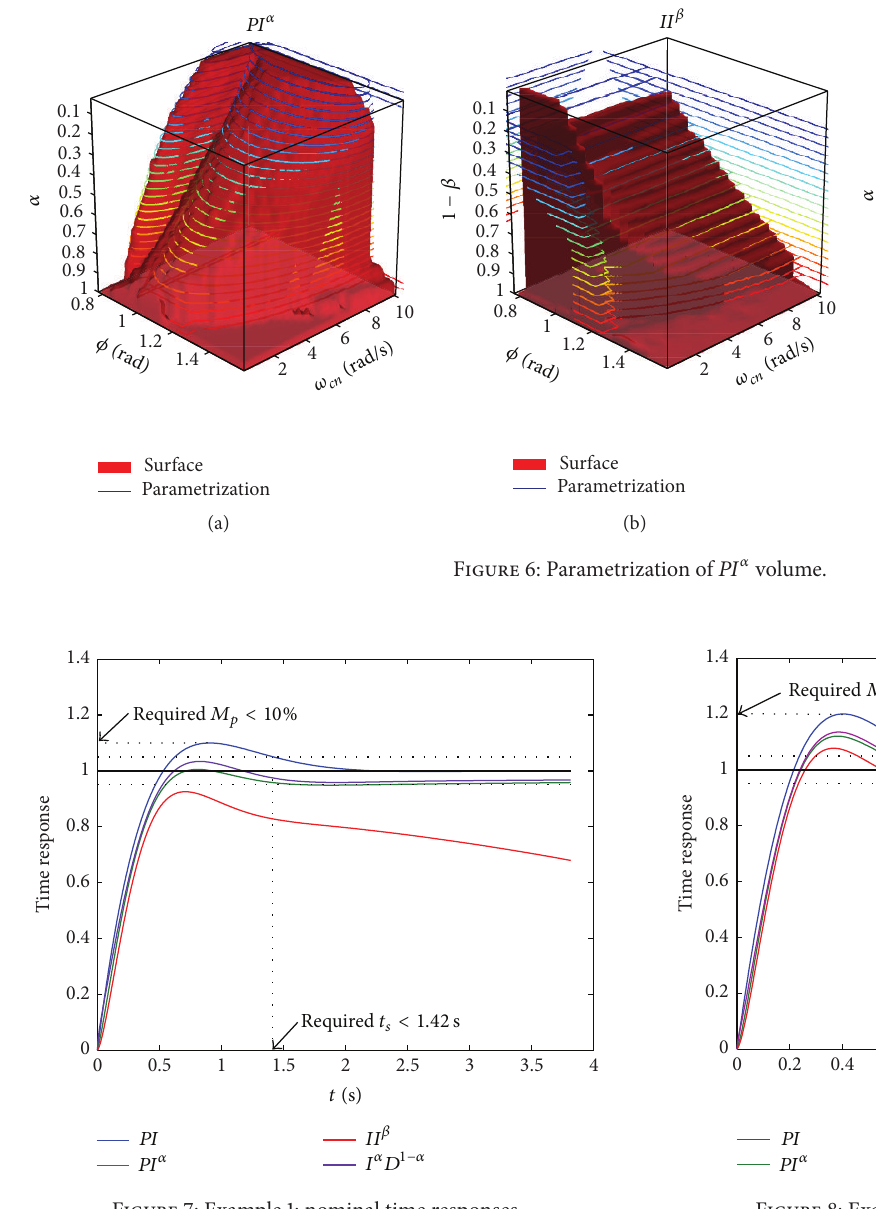
Figure 7: Example 1: nominal time responses. Figure 8: Example 2: nominal time